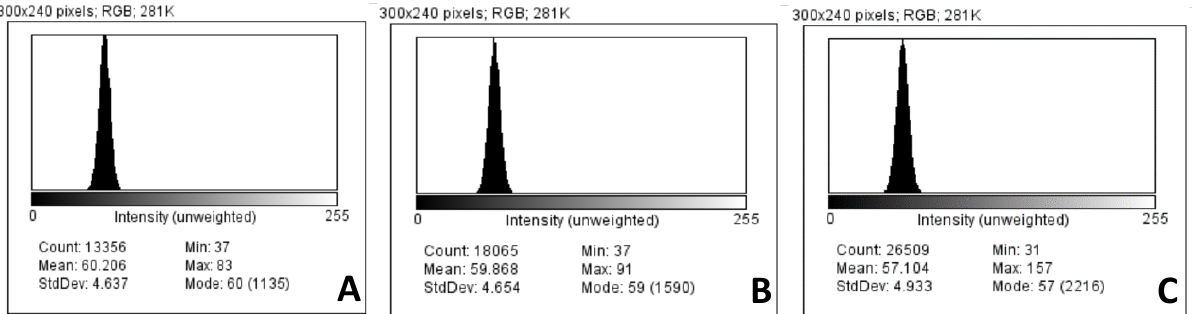
Figure 4. Exemplary histograms of mean brightness of the areas covering the tested tablets: ( A ) unexpired; ( B ) expired; ( C ) stressed.